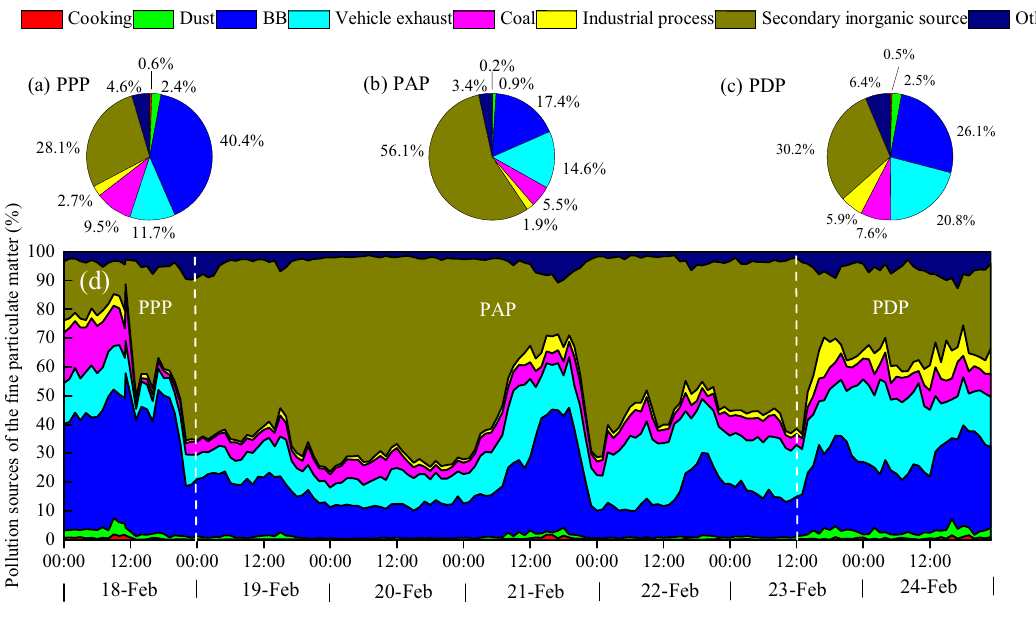
Figure 2. Temporal change for the percentage of single particle source